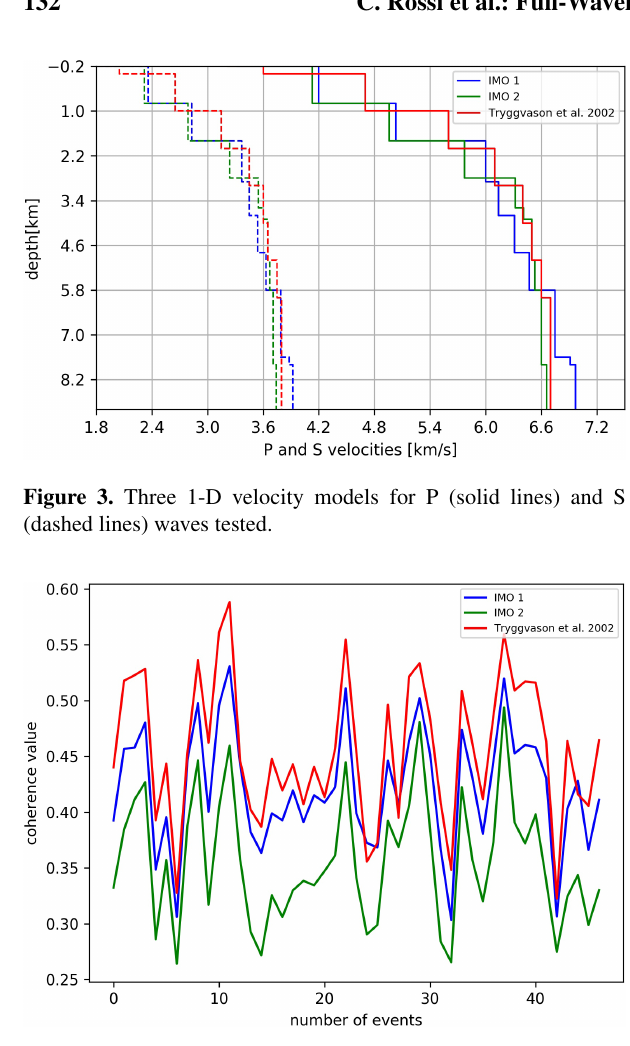
Figure 4. Coherence values for the three velocity models. The Tryg- gvason et al. (2002) model shows the best values of